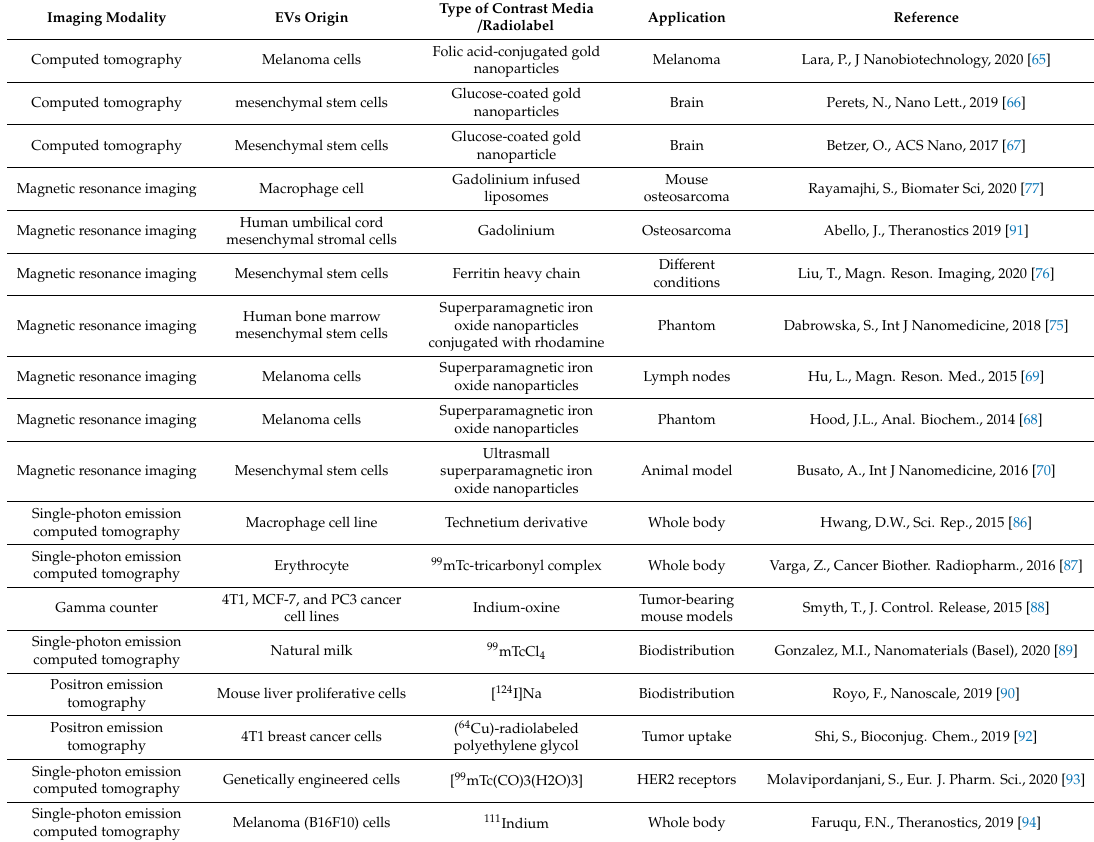
Table 2. Data showing the potential role of EVs as a contrast media or radiolabel in radiology and nuclear